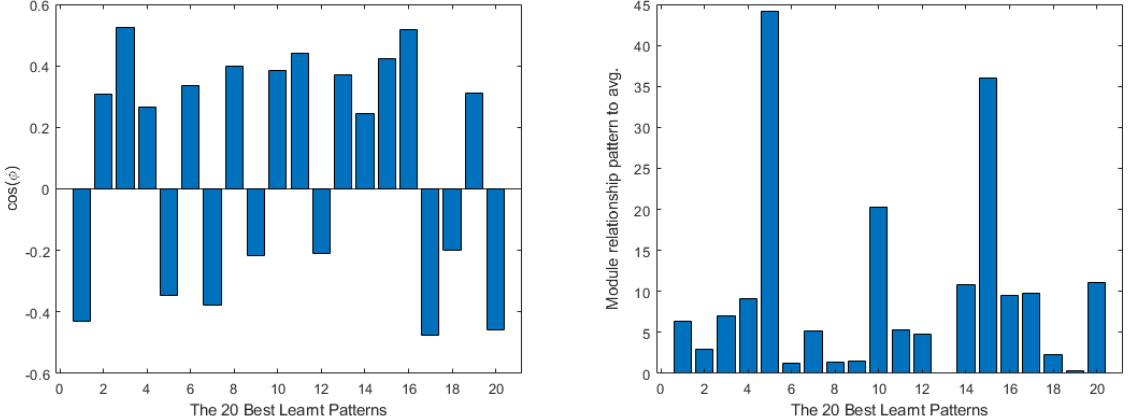
Figure 28. Unified worst learned patterns cos(φ) on the ( left ) and | 𝜕𝐿𝑜𝑠𝑠 | on the ( right ) for the drop-wave function using the modified SGD with dynamic alpha and drop-out.